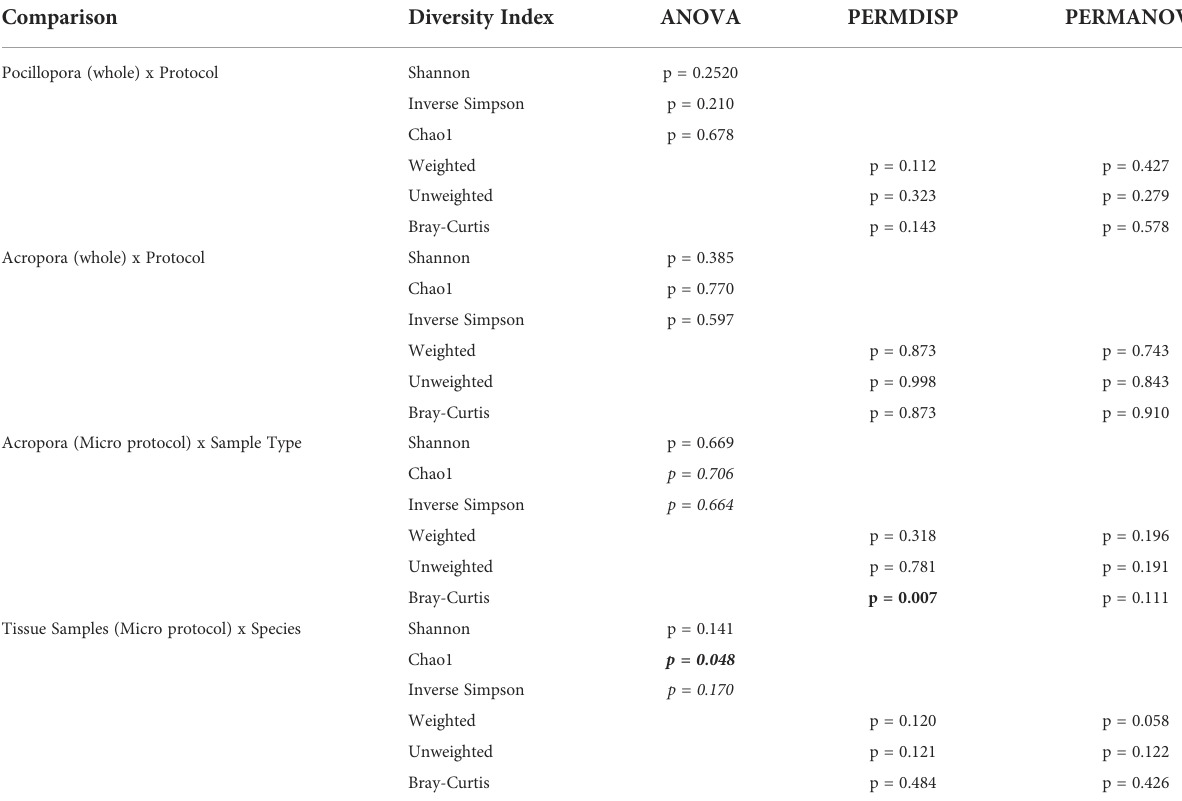
TABLE 2 Results for all alpha and beta diversity